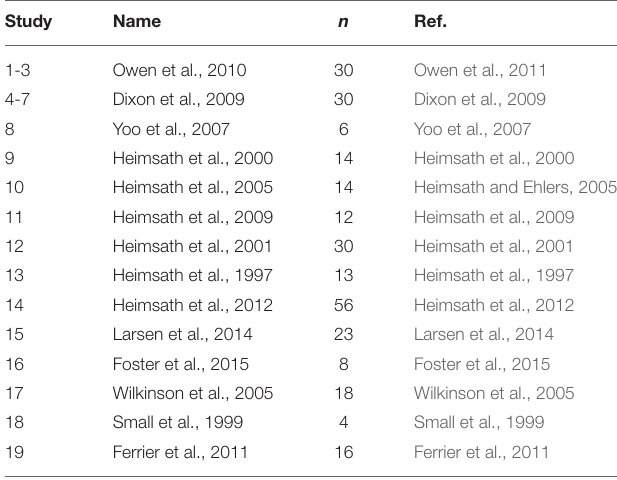
TABLE 1 | Global compilation of geo-referenced CRN-derived denudation rates used to calculate soil mass diffusivities reported in Figure 4 .